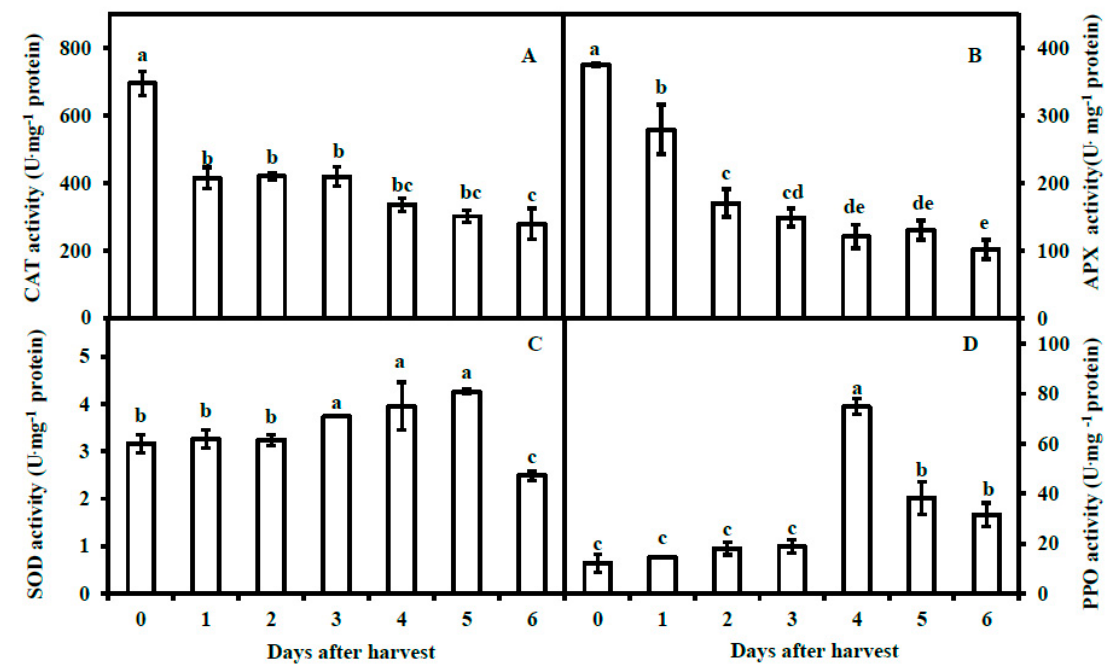
Figure 3. Antioxidase and polyphenol oxidase activity of pericarp of fruit stored at room temperature (25 ± 2 ◦ C) for 0 to 6 d. ( A ), CAT activity; ( B ), APX activity; ( C ), SOD activity; ( D ), PPO activity. Vertical lines represented the standard deviation of the means of three replicates. Different small letters indicated significant difference at p < 0.05. Table 1. Summary of transcriptome of pomegranate